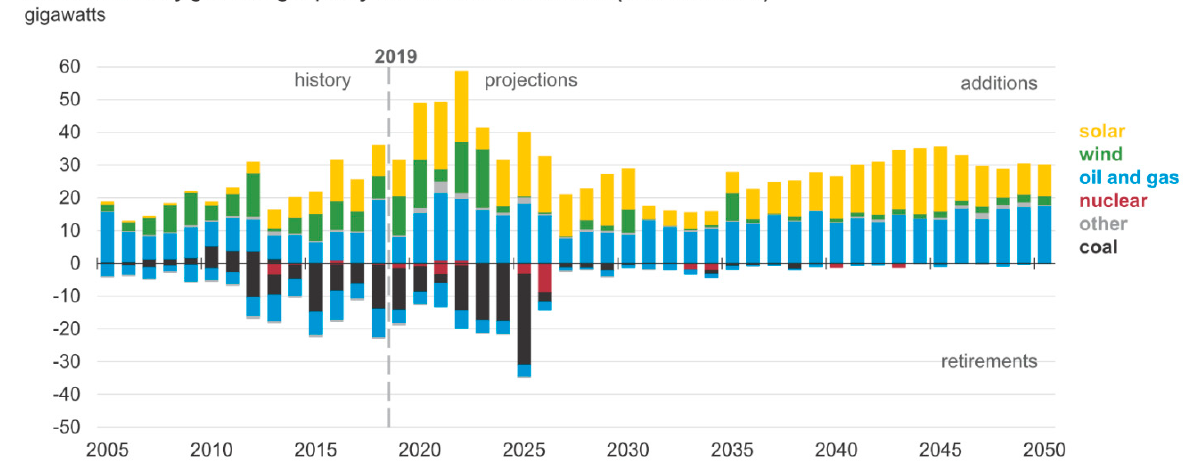
Figure 3. Application of renewable energies in the future [4].